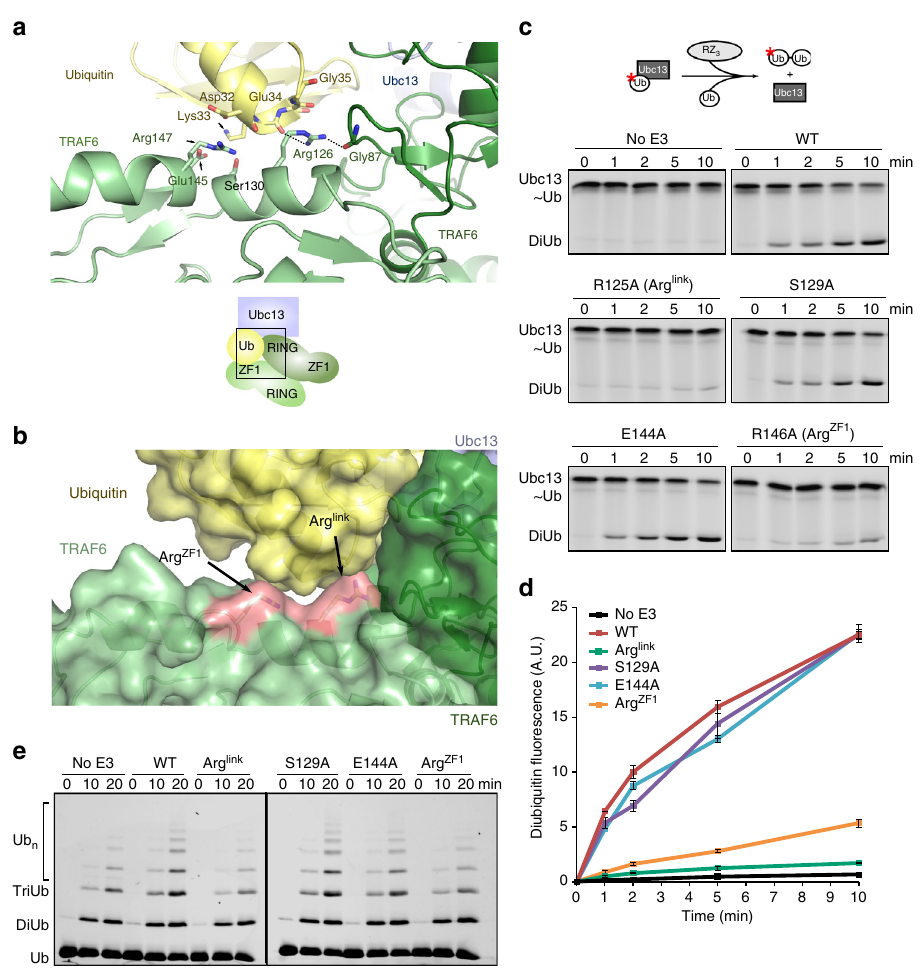
Fig. 2 The linker-helix and ZF1 of TRAF6 stabilise ubiquitin so that it is primed for attack. a Details of the molecular contacts between the RING dimer (two shades of green) and ubiquitin from the RZ 1 complex (chains A, B and C). Predicted polar contacts are indicated with dashed lines. Carbon atoms coloured as in Fig. 1d, oxygen and nitrogen atoms coloured in red and blue, respectively. Numbering is as for D. rerio TRAF6. b Surface representation of the TRAF6 – ubiquitin interaction. Critical residues for stabilisation are in pink. Arg126 is labelled as Arg link ; Arg147 as Arg ZF1 . c Ubc13 conjugated to fl uorescently labelled ubiquitin was used in discharge assays in combination with no E3, wild-type Hs RZ 3 , or mutant forms of TRAF6 as indicated. d Quanti fi cation of the formation of diubiquitin. Each experiment was performed in duplicate; error bars indicate range of measurement. e Chain-building assay using the same mutants as in panel c . Reaction mixture was spiked with 10% fl uorescently labelled ubiquitin to allow visualisation of the